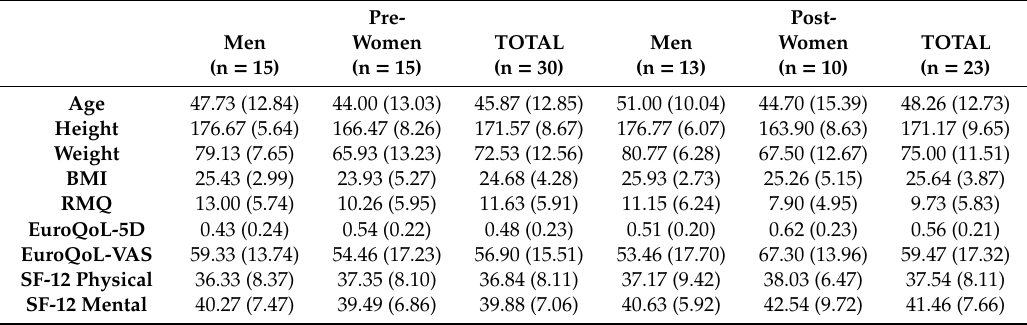
Table 1. Anthropometric and questionnaire data of the sample (baseline and 1 month later). Body mass index (BMI); Roland-Morris questionnaire